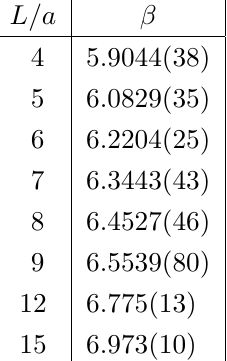
Table 15 . Couplings corresponding to g 2 ( L ) ’ 3 : 48 in the SU(3) theory, as a function of L=a , reproduced from ref. [32, table 3].